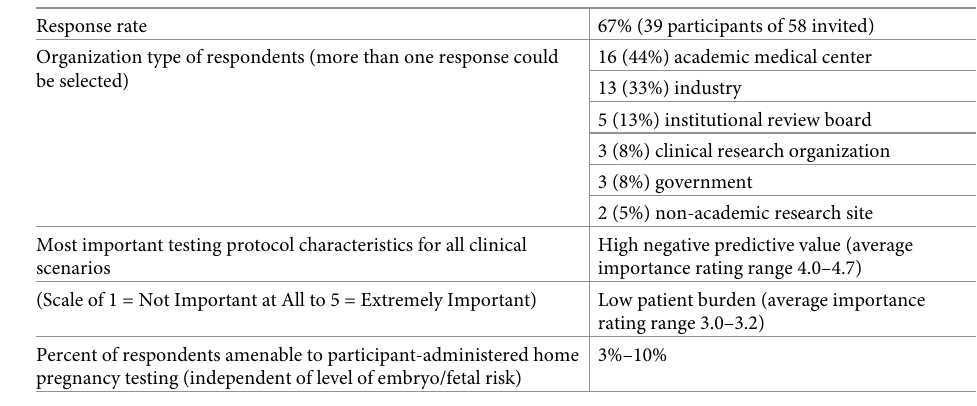
Table 1. Survey summary